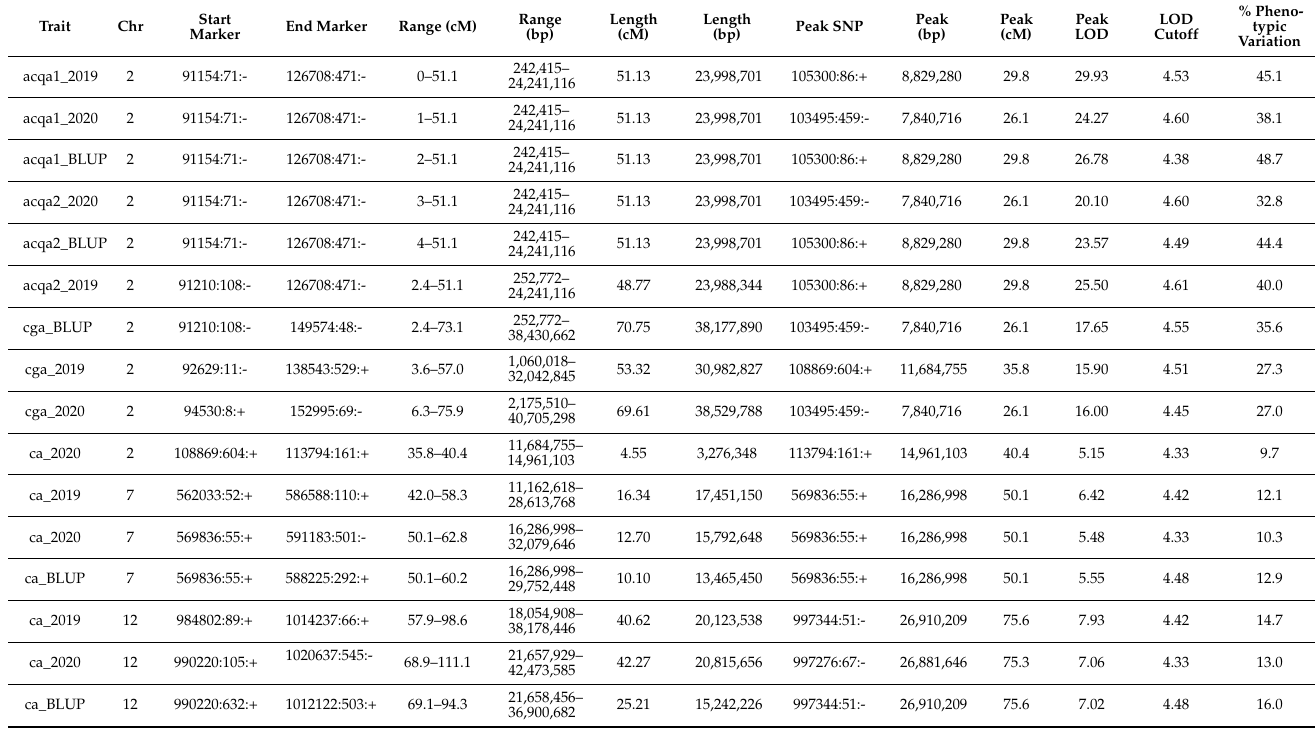
Table 5. Significant QTL identified. The chromosome on which the QTL is located, the marker interval of significant SNPs (above the LOD cutoff), the range and length of the significant interval in both cM and bp, the peak SNP, its location in cM and bp, the LOD score of the peak SNP, the LOD score cutoff for significance, and the percent observed phenotypic variation explained by the QTL are